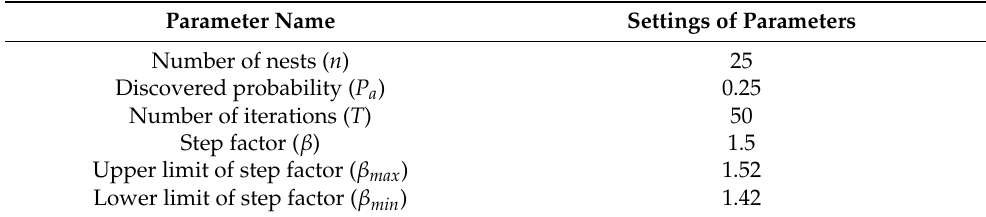
Table 3. Settings of parameters applied in the improved cuckoo algorithm.